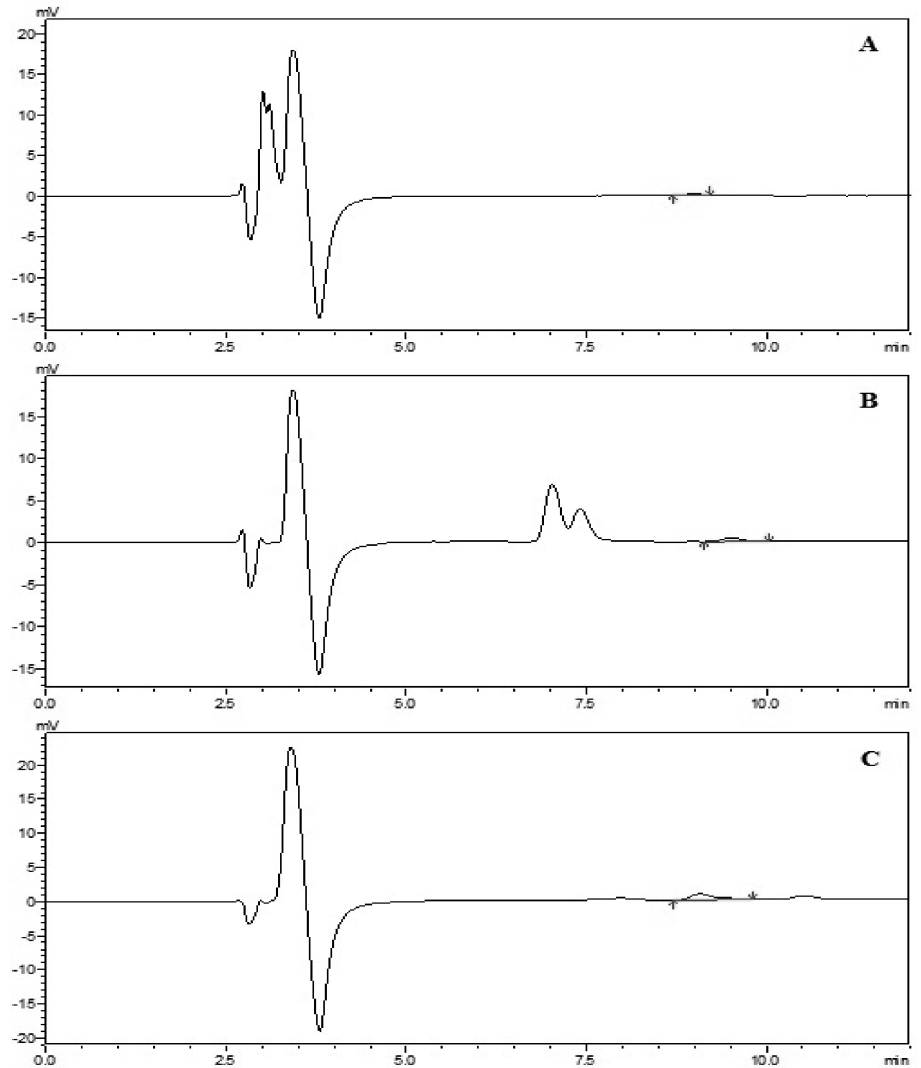
FIGURE 2 - Chromatograms corresponding to: (A) solution of MUP time 24 hours after acid hydrolysis, (B) solution of MUP time 24 hours after basic hydrolysis and (C) solution of MUP time 24 hours after photolytic conditions.